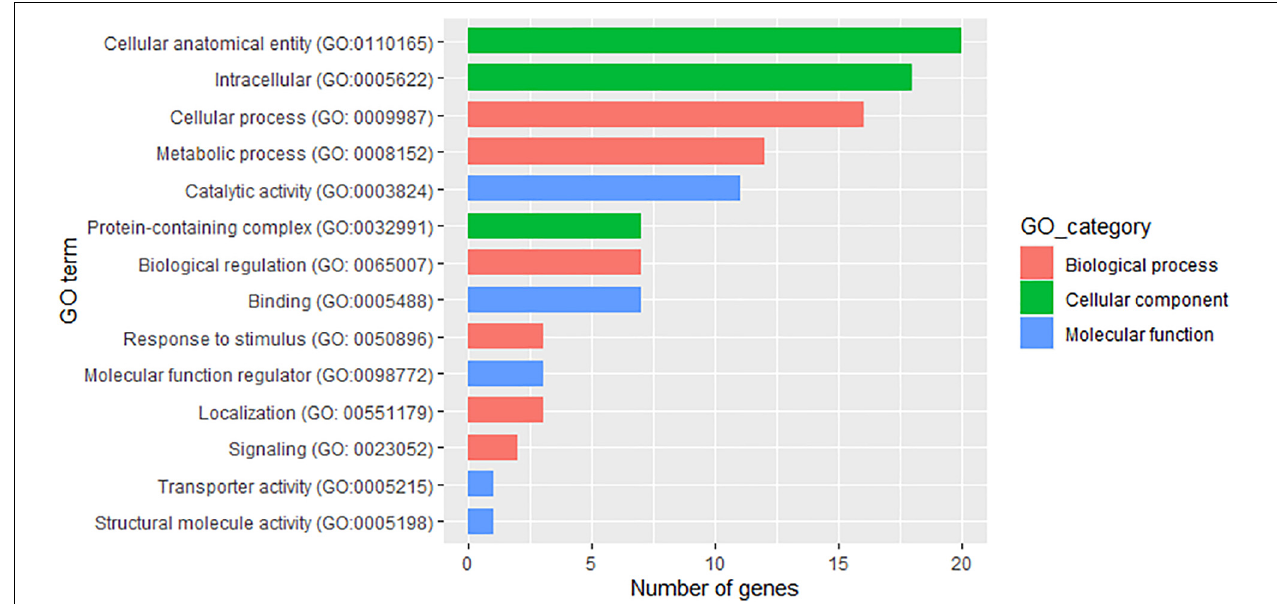
FIGURE 6 | Attributes of the 43 putative genes identified in the vicinity of the single nucleotide polymorphism (SNP) markers associated with weevil resistance